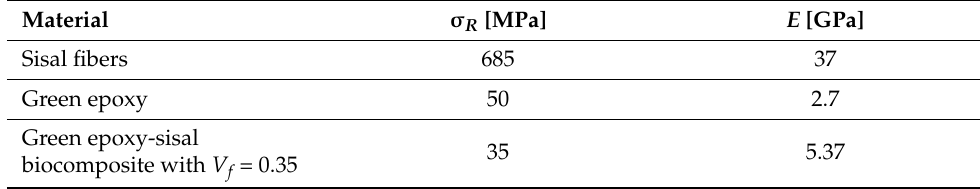
biocomposite with V f =